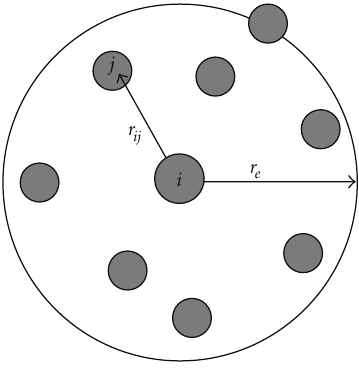
Figure 2: Particle interaction